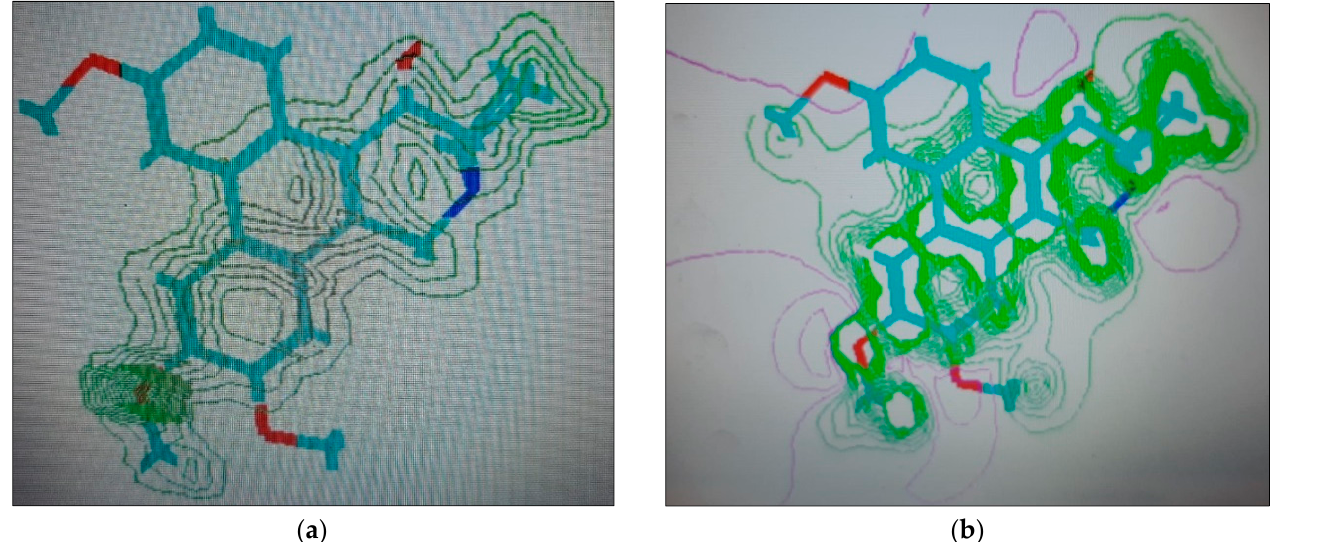
Figure 7. Structure ( 3 ) (tylophorinine), 2D renderings: ( a ) charge density localizations; ( b ) electrostatic potential.